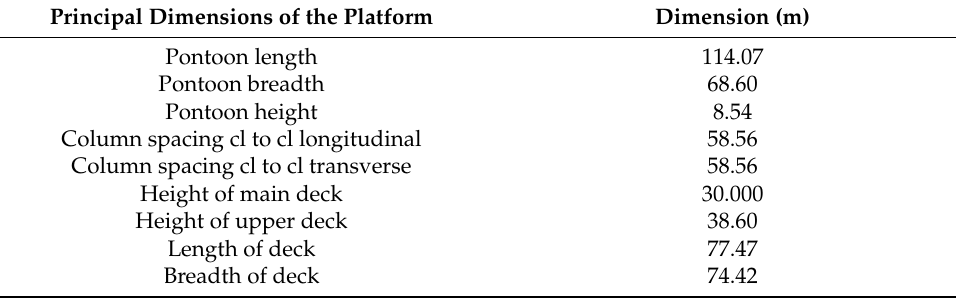
Table 1. Principal dimensions of the platform under